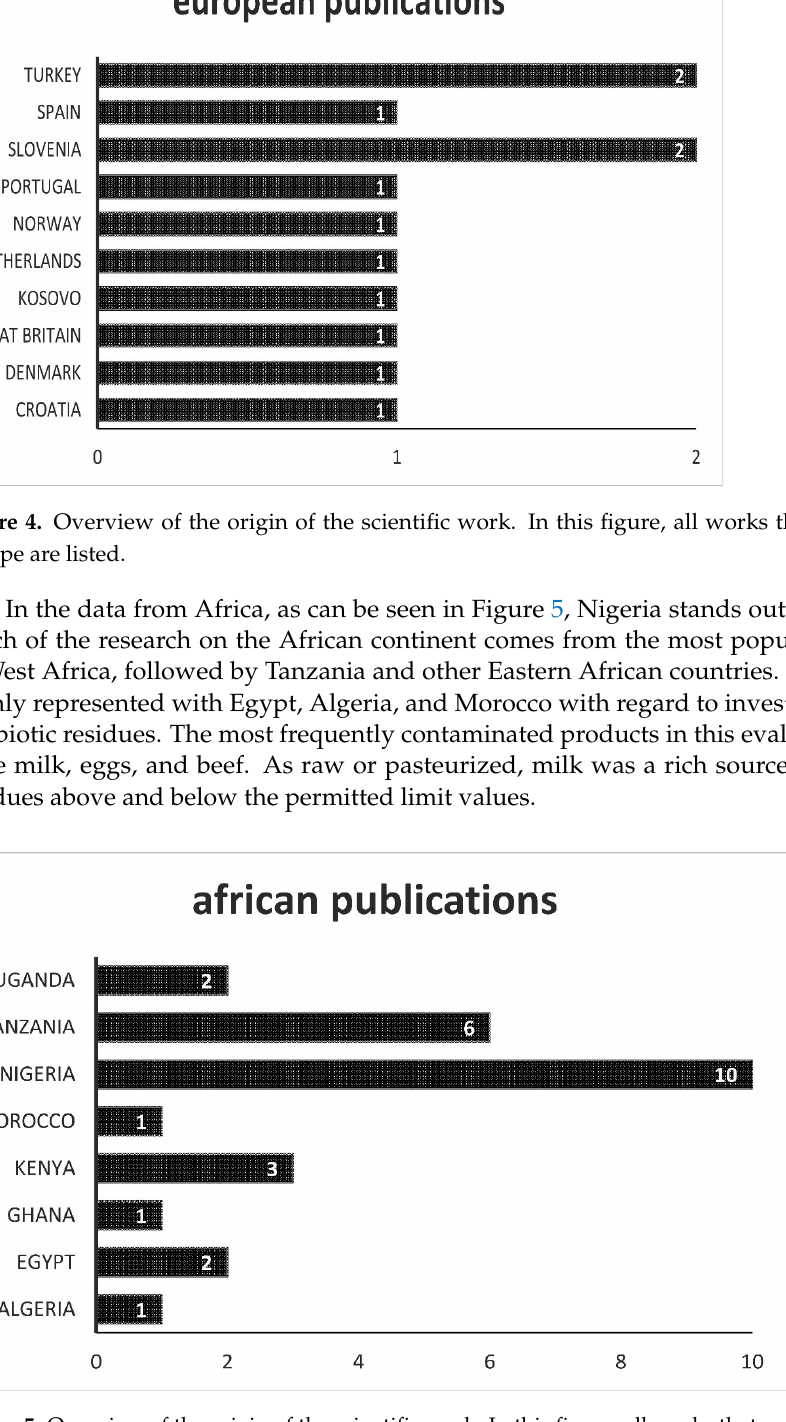
are checked by state agencies and published nationally in annual reports.